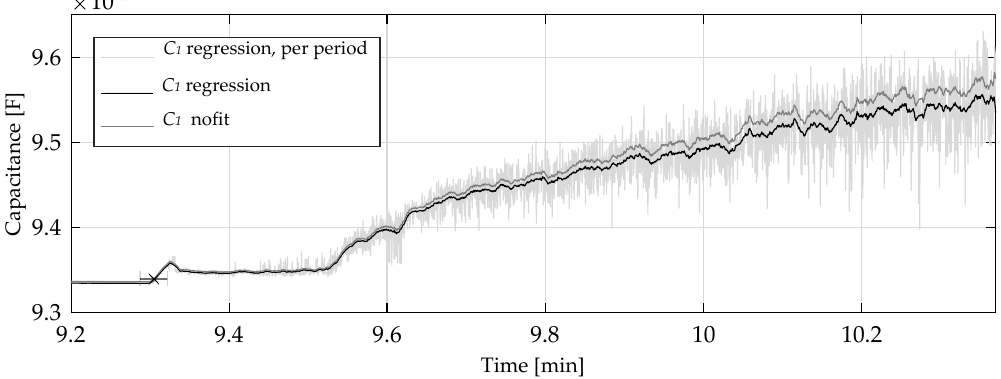
Figure 10. The actual voltage u 2 as well the fit resulting from the regression calculation and Heun’s method during 1.5 periods of an experiment after the inception of an electrical tree. Energies 2020 , 13 , x FOR PEER REVIEW